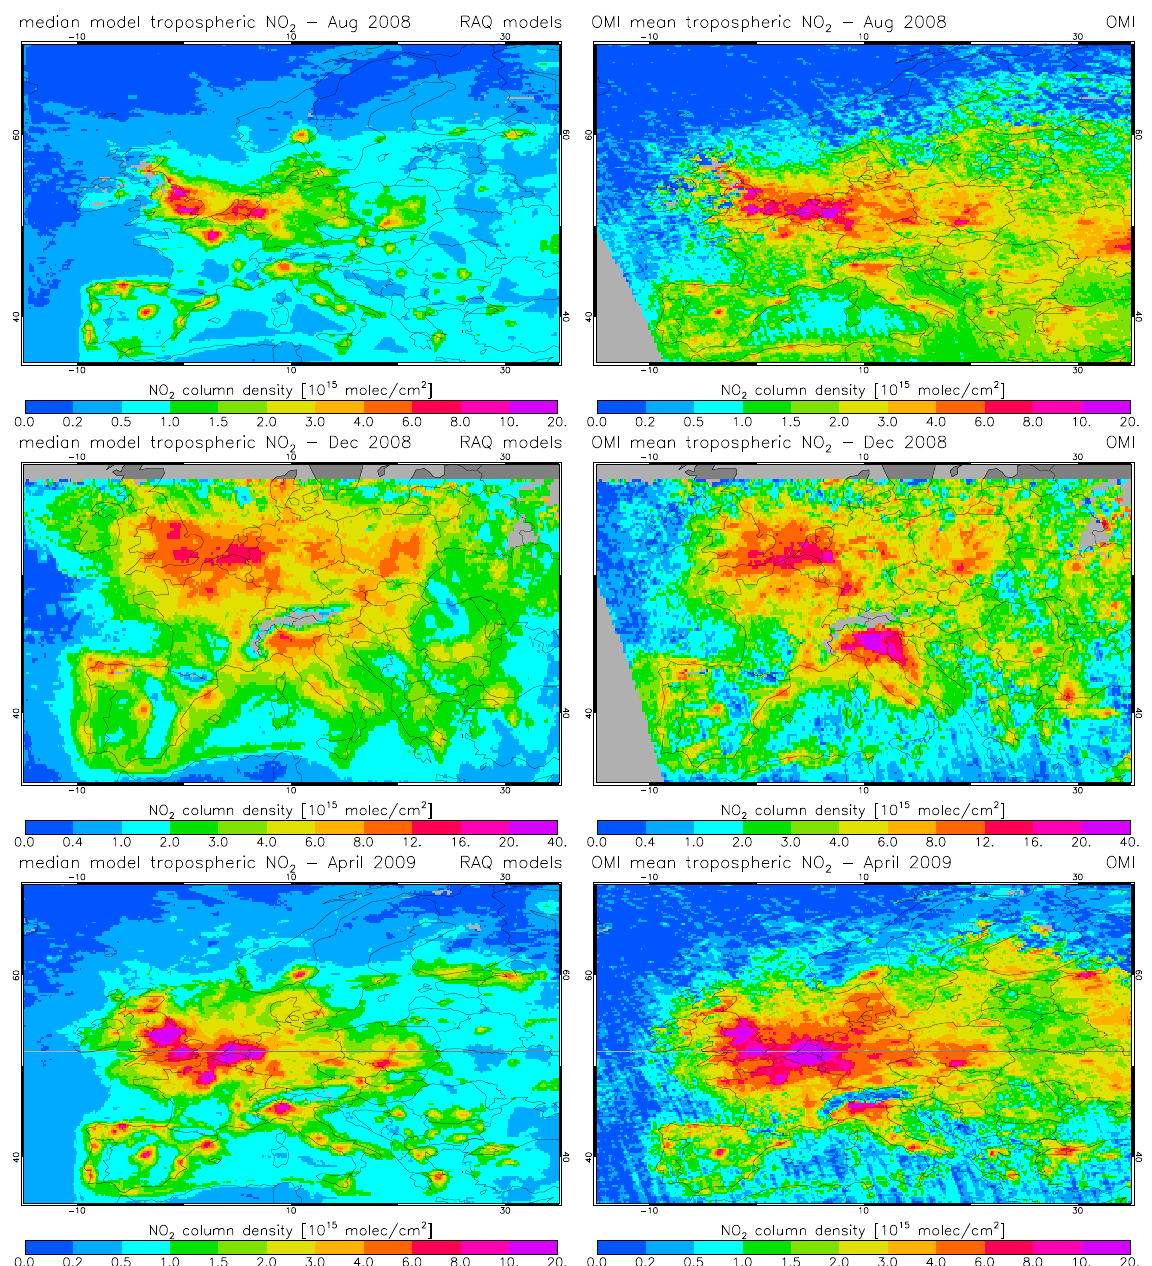
Fig. 3. Ensemble median tropospheric NO 2 columns in August, December 2008 and April 2009 based on all RAQ models, versus OMI. Note the different colorscale in